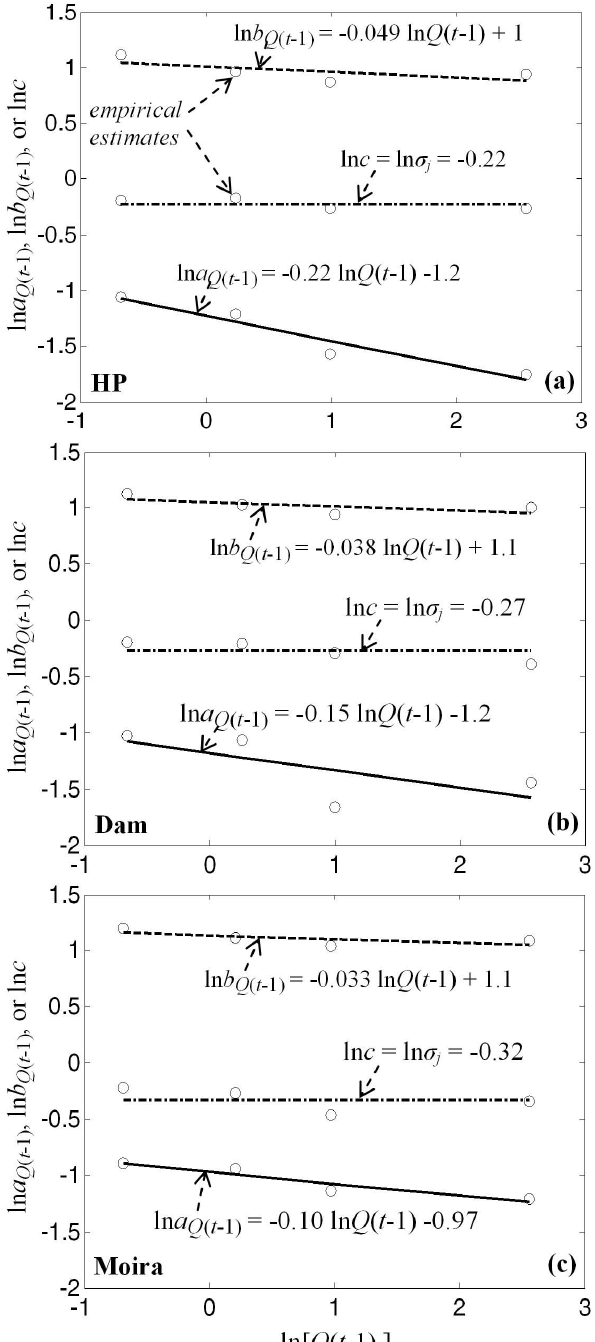
Fig. 9. Plots of the parameters a j and b j ( j =1, ..., 4) in Eq. (4), and the error standard deviation σ j =Var[ V j ] 0 . 5 as functions of the previous-day river discharge Q(t − 1), for the rainfall data sets used in Figs. 6–8. Lines correspond to least-squares (LS) fits to the em- pirical values.